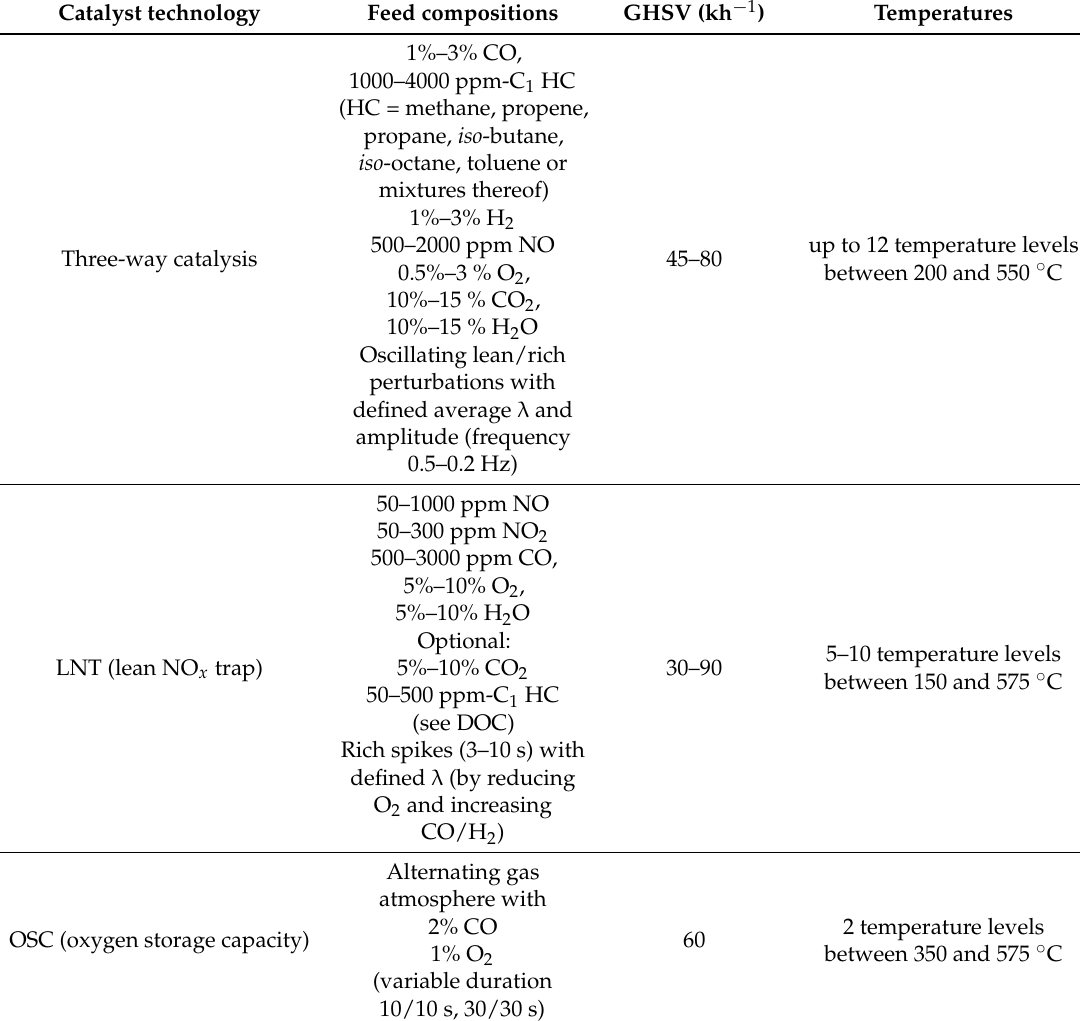
Table 2. Overview of dynamic test protocols with fast feed